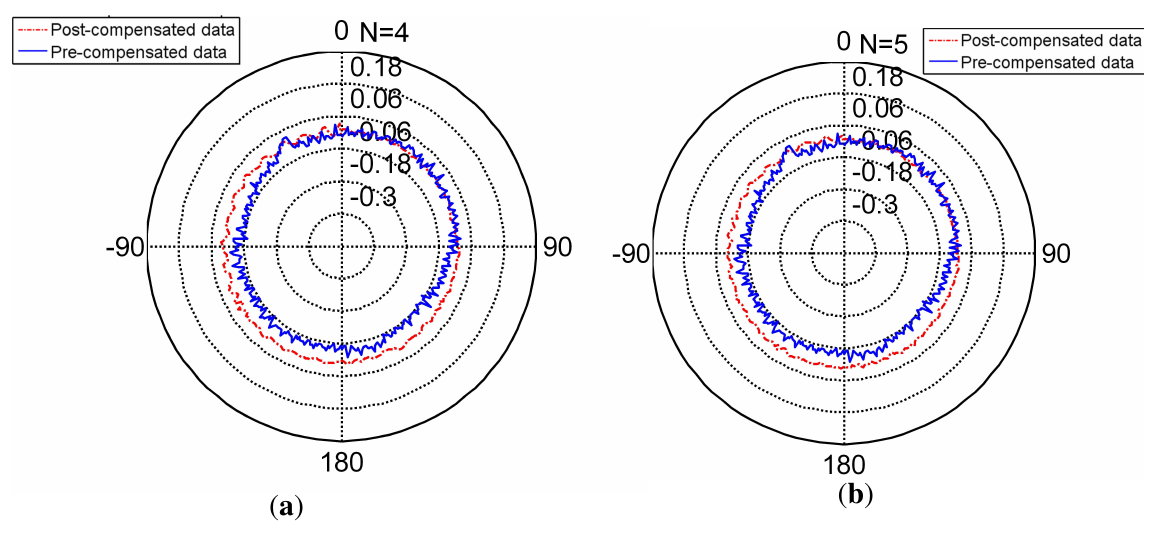
Figure 11. Compensation for separating factor four and five. ( a ) separating factor four; ( b ) separating factor five.